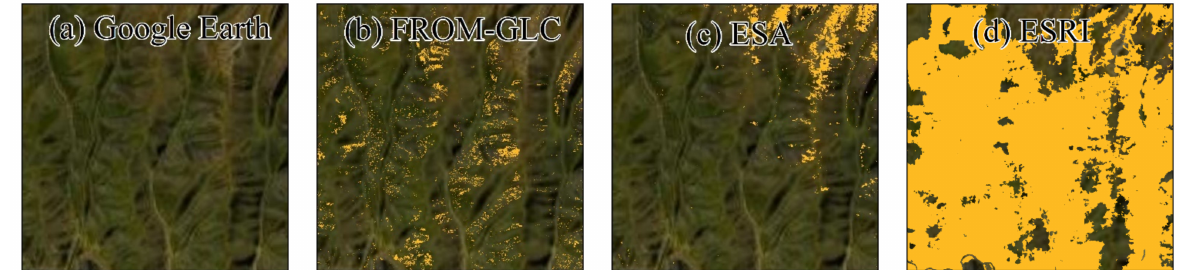
Figure 12. Visual comparison of shrubsland type with Google Earth image (orange is